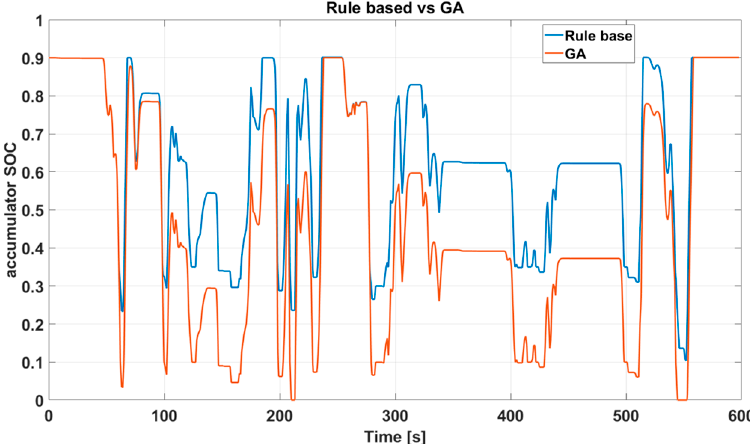
Figure 17. Comparison between HEHV (rule-based) and HEHV (GA) accumulator SOC .